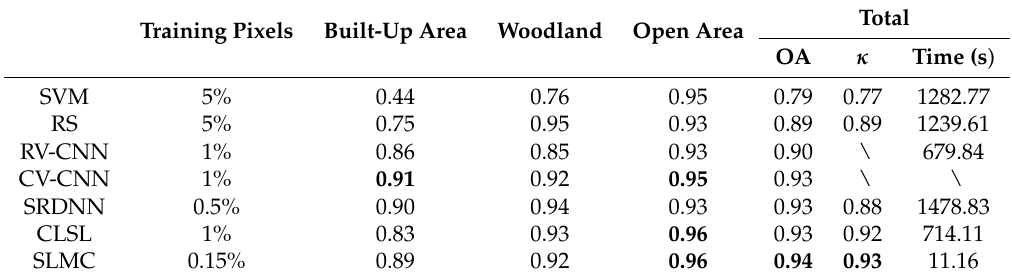
Table 5. Classification accuracy on dataset